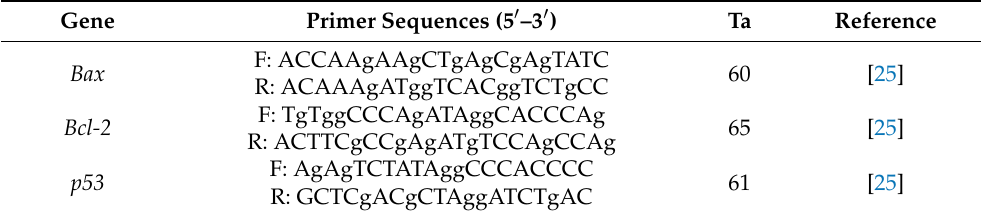
Table 1. Primers used real-time PCR analysis of selected genes and the corresponding annealing temperatures (Ta, ◦